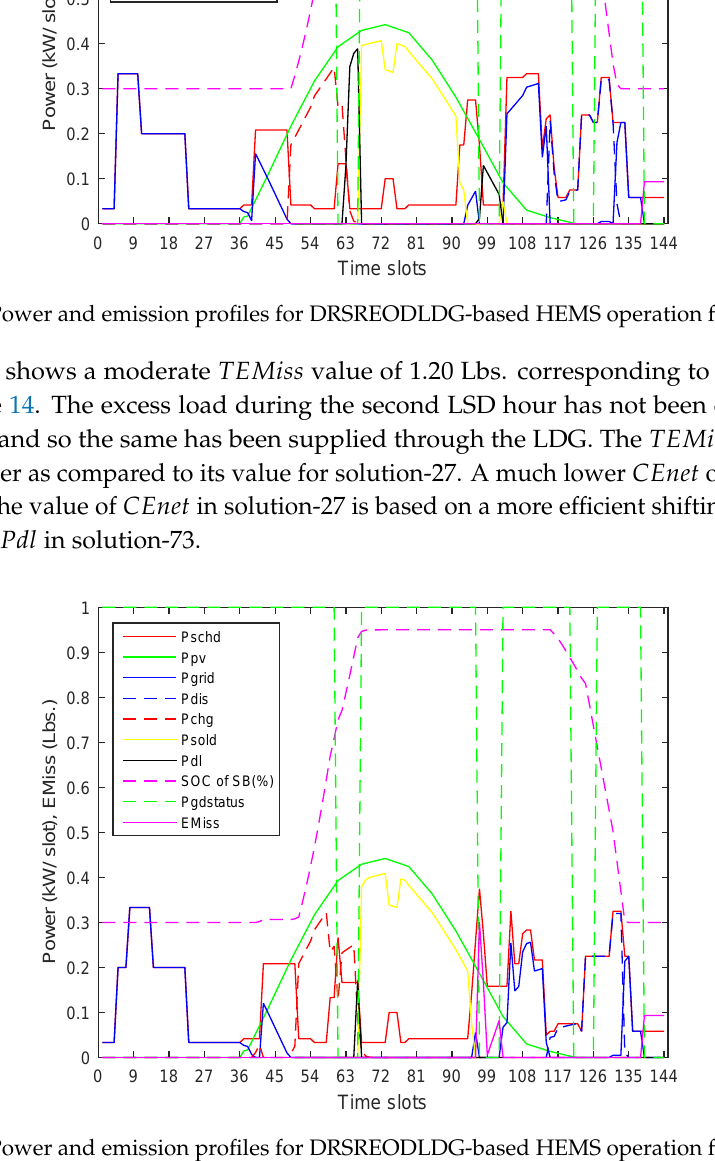
Figure 14. Power and emission profiles for DRSREODLDG-based HEMS operation for